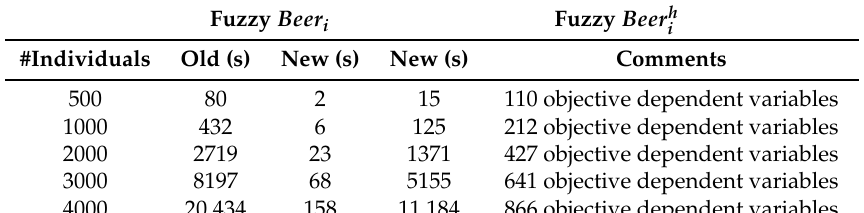
Table 8. Running time (s) for subsets of the Fuzzy Beer ontology.